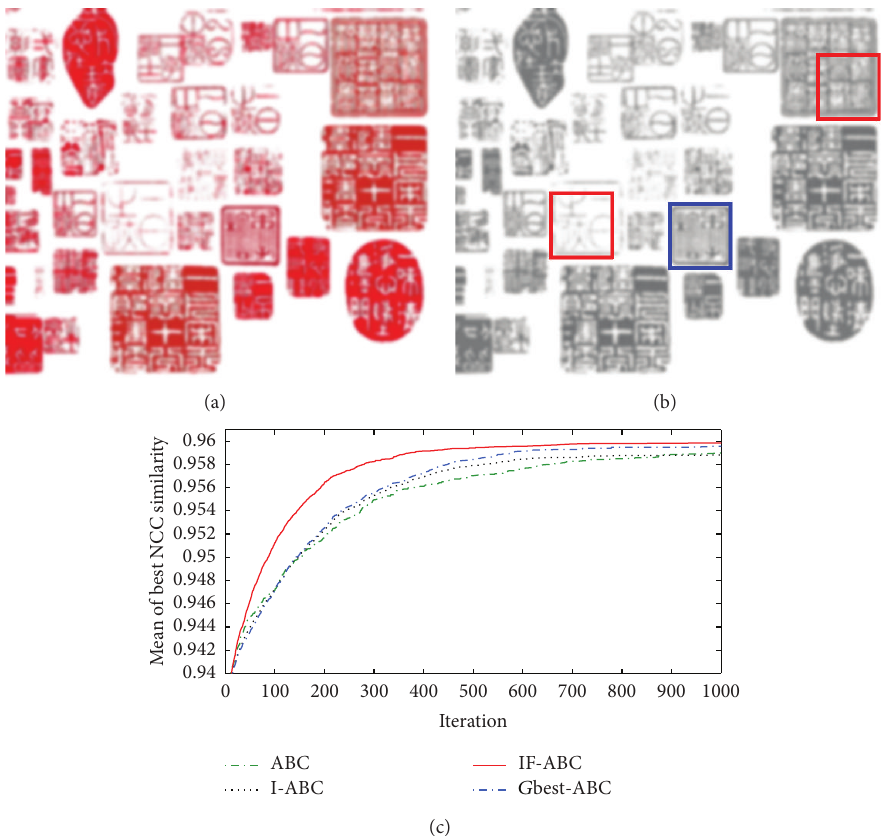
Figure 9: Practical template matching case 2. (a) Gaussian blurred source image; (b) ground matching truth (blue box) and most common false matching results (red boxes); (c) comparative evolution curves of four ABC